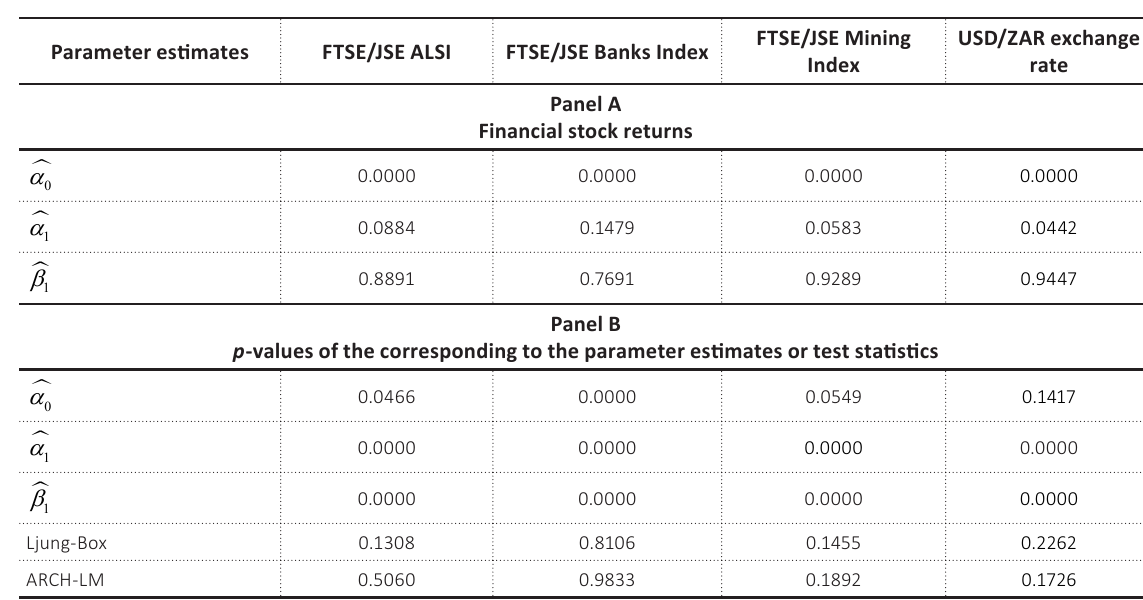
Table 2. ML parameter estimates for GARCH (1,1) model with normal innovations and corresponding goodness-of-fit statistics for Financial stock